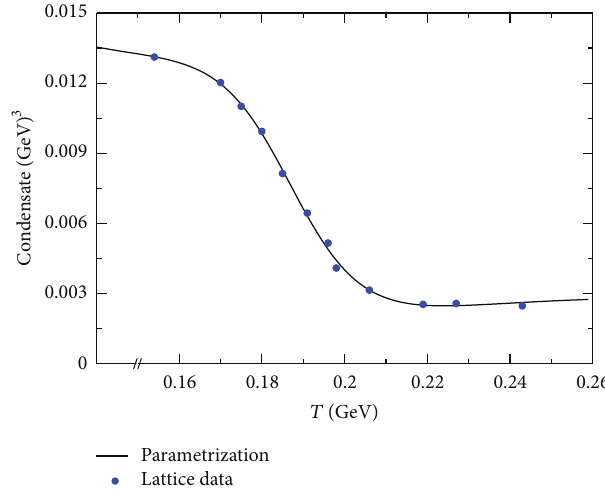
Figure 23: LQCD data (dots) [62, 63] and absolute value of the quark-condensate, ⟨𝜓𝜓⟩(𝑇) (81) (solid curve), as a function of 𝑇 in the phase transition (or crossover) region.